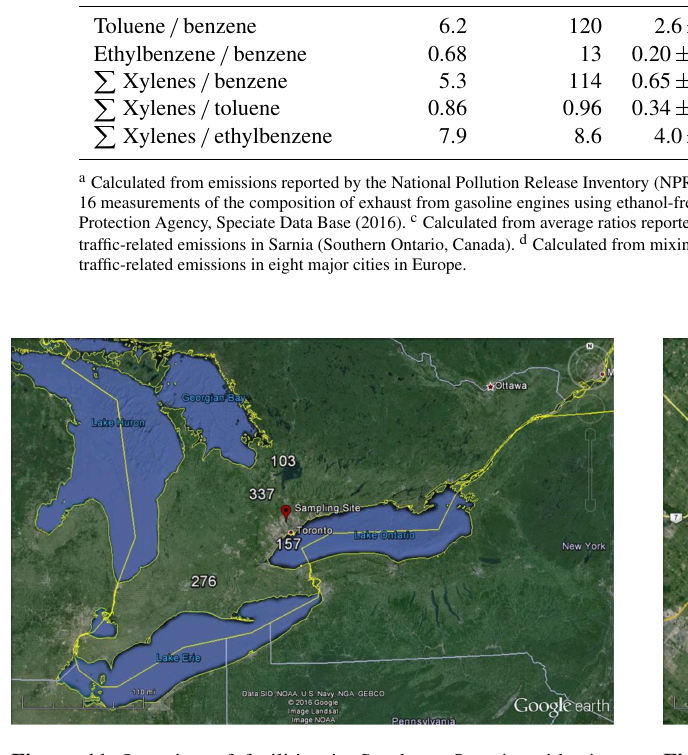
Table 14. Comparison of observed VOC concentration ratios (molmol − 1 ) with VOC emission ratios for industrial facilities and mobile transportation. VOC concentration Facilities in Facilities in Gasoline Traffic in Traffic in eight Average of all ratios Ontario a Toronto a engines b Sarnia c European cities d observations Toluene / benzene 6.2